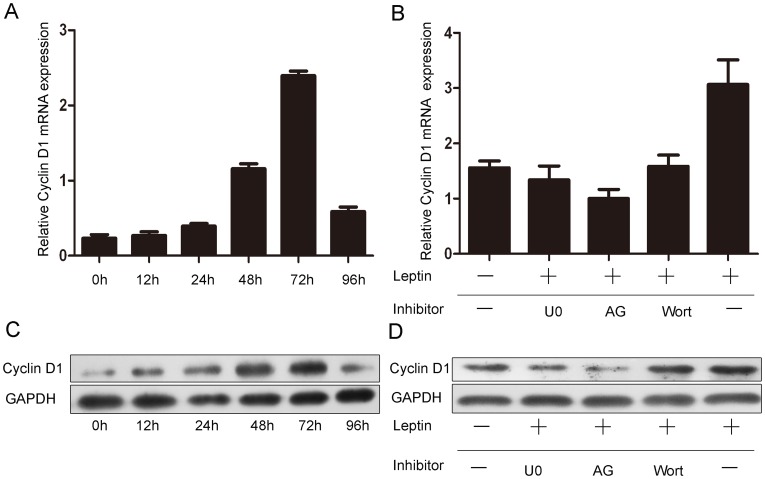
Crosstalk among JAK/STAT3, PI3K/Akt, and MEK/ERK pathways in leptin-stimulated NP cells.After 1-day serum deprivation and then 30-min pre-treatment of vehicle (−), 10 µM U0126 (U0126), 40 µM AG490 (G) or 250 nM wortmannin (Wort), NP cells were treated with vehicle (−) or 10 ng/ml leptin (+) in serum-free media for 30 min respectively. Following, the protein amounts of phosphorylated of Akt (p- Akt) (A), ERK1/2 (p- ERK1/2) (B) or STAT3 (p- STAT3) (C) were detected with western blotting analyses. The same blots were stripped and reprobed with antibodies specific for total proteins of Akt, ERK1/2, or STAT3. GAPDH was also detected for a loading control. Data represent three independent expriments.